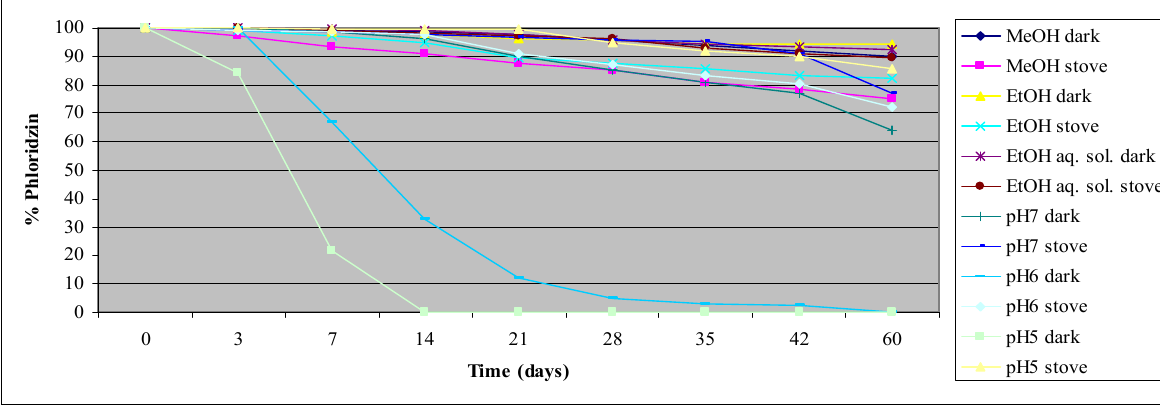
Figure 1. Phloridzin stability in solution at different pH values and storage